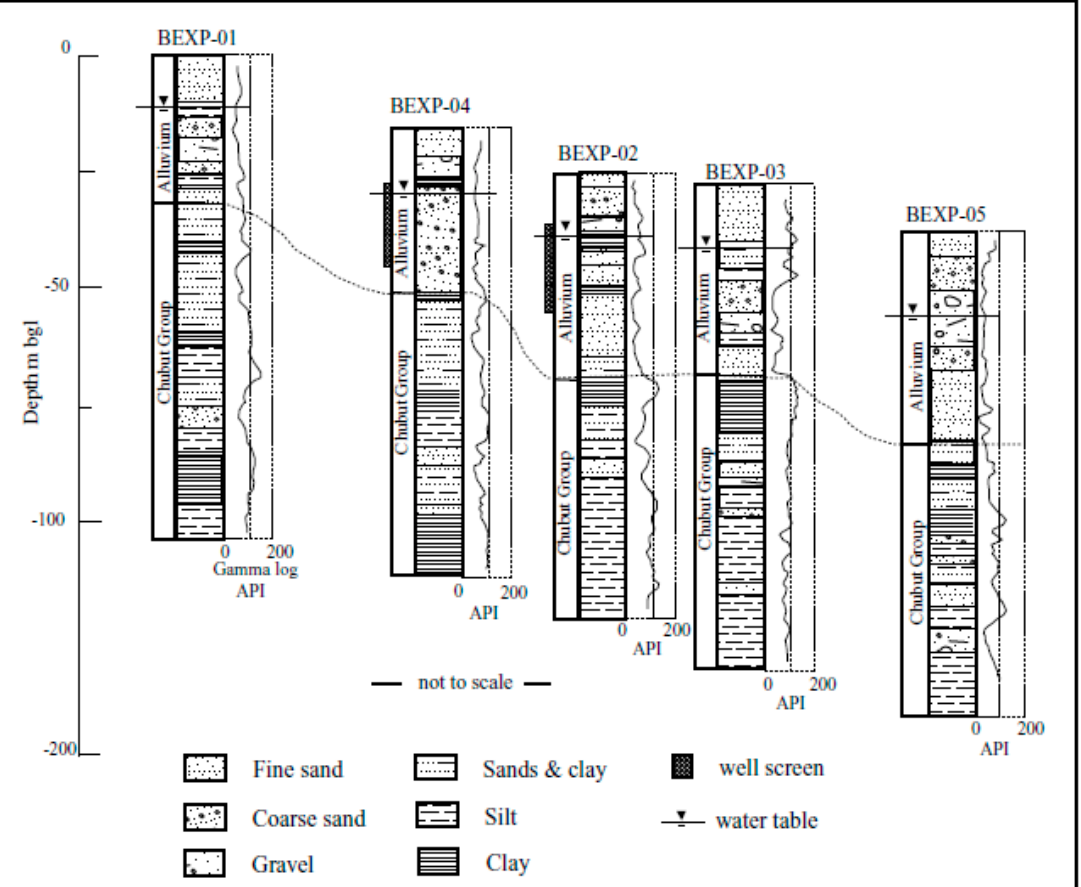
Figure 2. Exploration boreholes and geological interpretation of intercepted units.